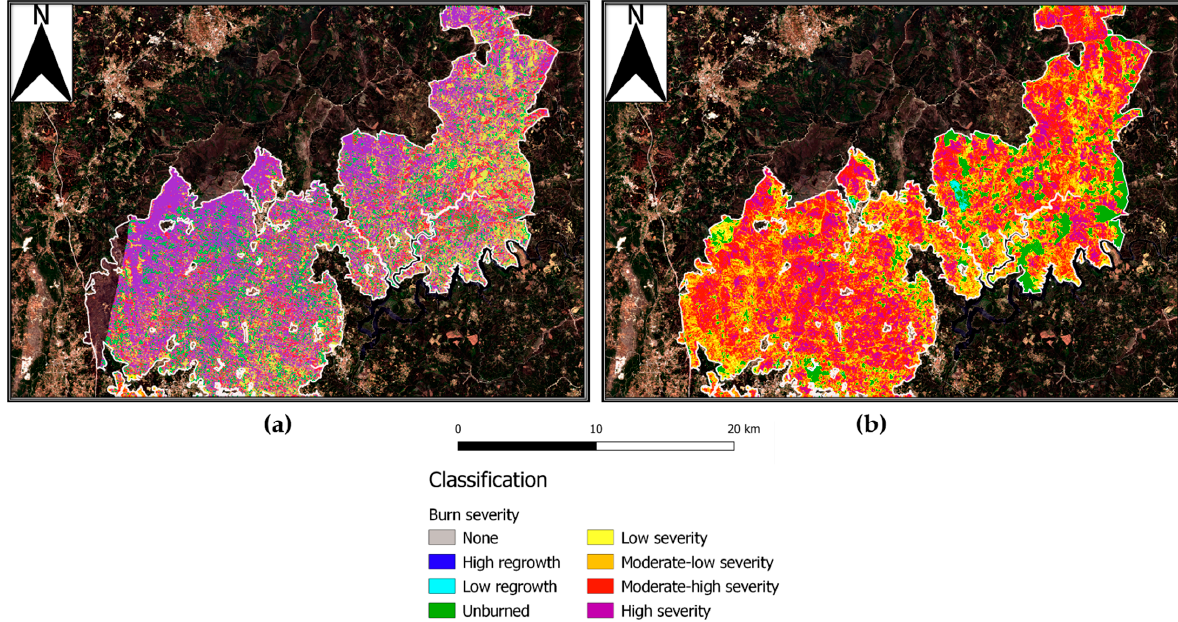
Figure 14. ( a ) PRISMA image classified based on the RBR severity classes spectral library with the application of a fire perimeter mask; ( b ) Sentinel-2 RBR severity map with the fire perimeter mask.